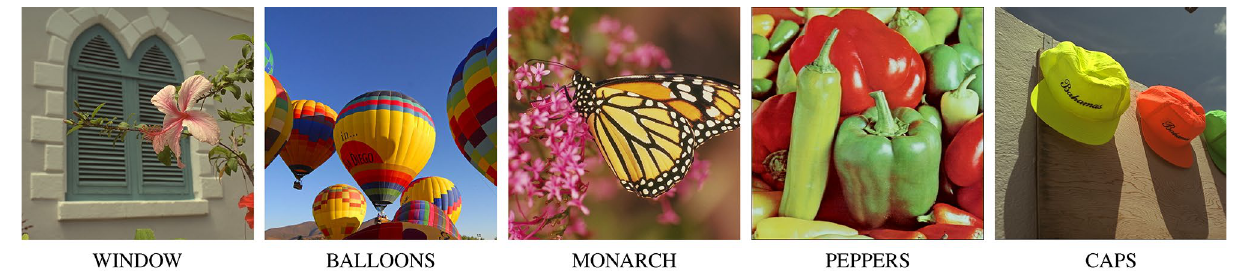
Figure 3. Color test images used in the evaluation of the new filter